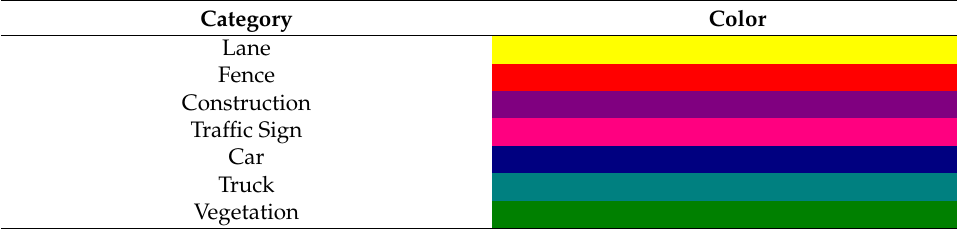
Table 2. Details of mark labels in the dataset.